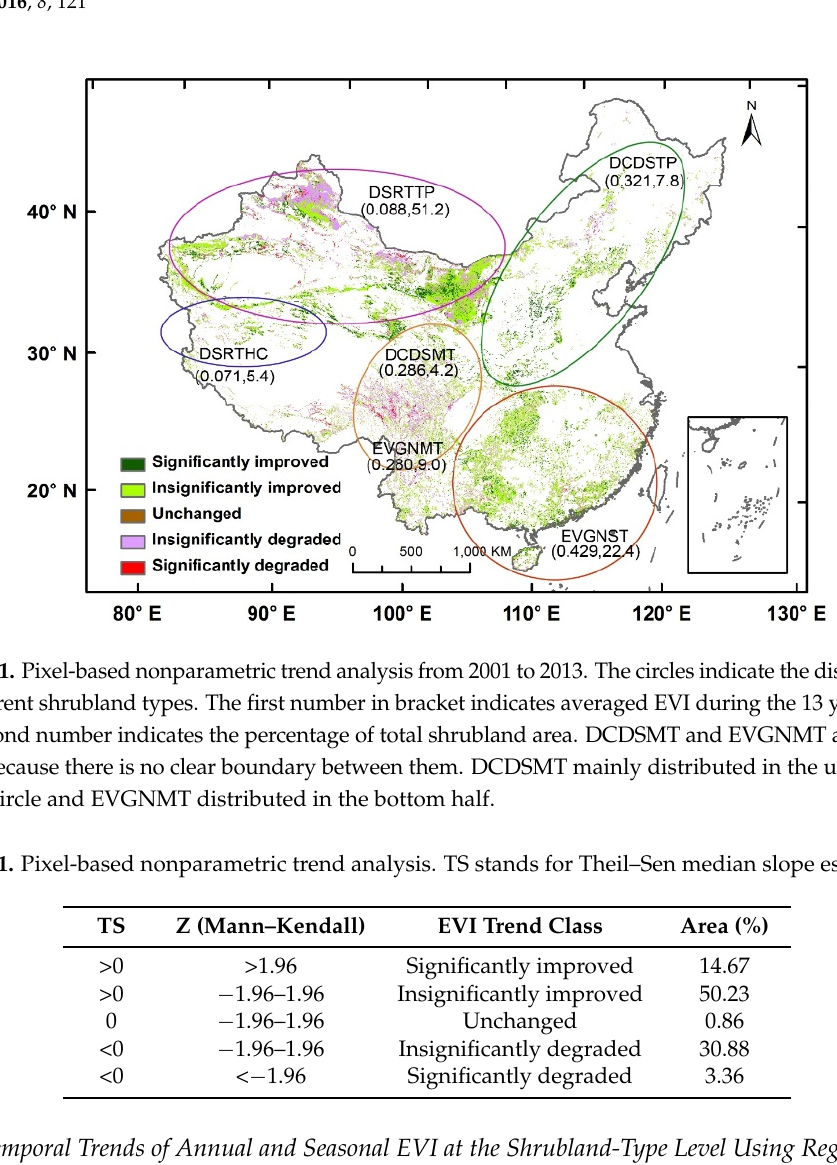
Table 2. Temporal trends in annual and seasonal EVI based on the Generalized Least Squares Regression. k denotes Linear coefficient for year. Δ R is the relative change computed as the slope k in the second column times 13 then divided by the annual average EVI in 2001. CONTRY denotes the pooled EVI of the countrywide shrublands; p values were based on one-tailed hypothesis, and “*”, “**”, and “***” are for p -values less than 0.1, 0.05, and 0.01, respectively. Annual Spring Summer Fall k (10 − 3 EVI ∙ a − 1 ) Δ R (%)